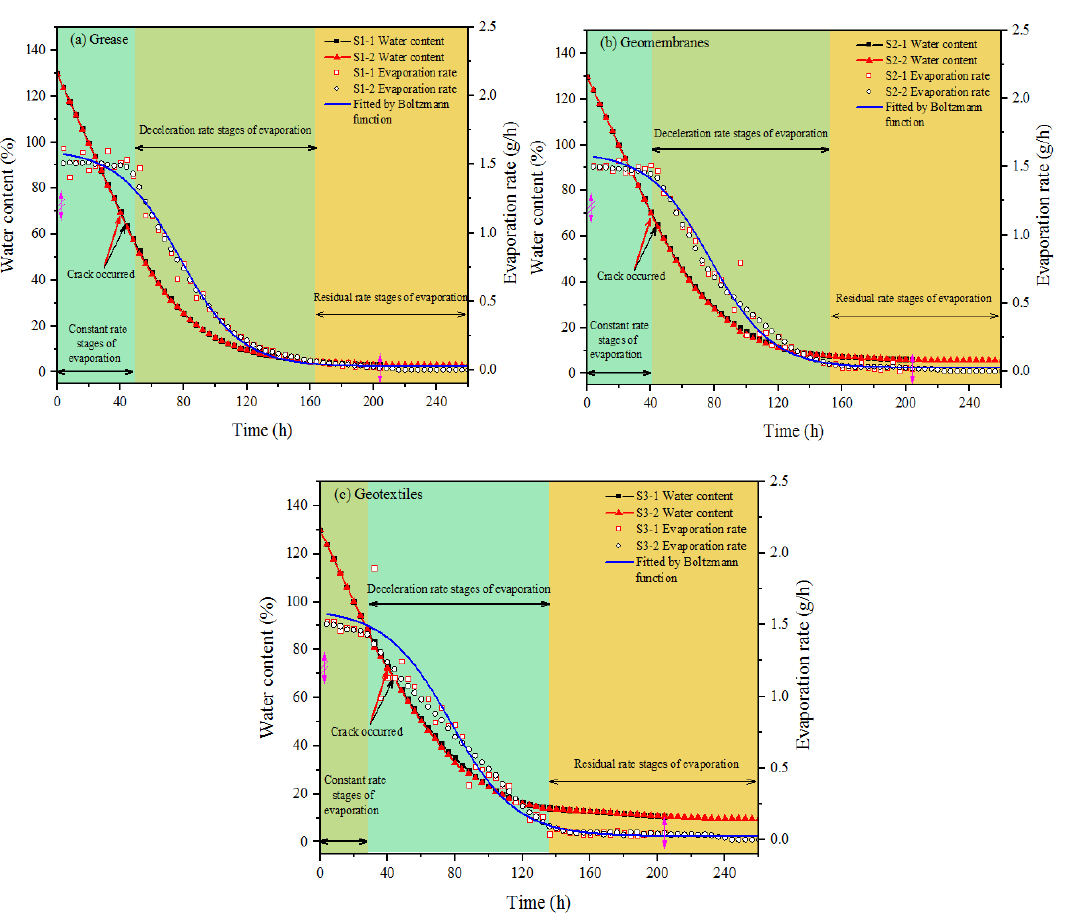
Figure 5. Water content and evaporation of soil samples versus time. ( a ) Grease, ( b ) geomembranes, ( c ) geotextiles.